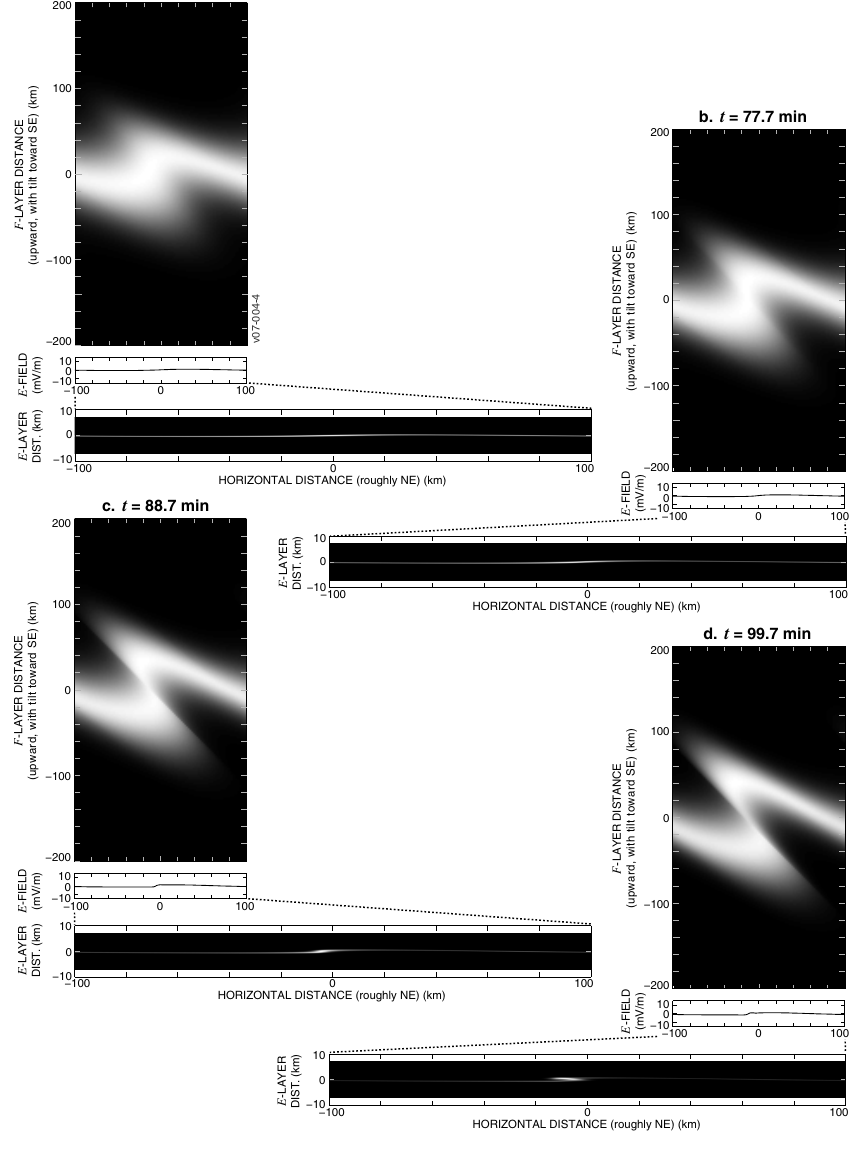
Figure 8: Coupled system evolution under resonant condition, with Σ H Σ = 1 . 0, and the E s layer at 105 km altitude. The PF boundary conditions are periodic in the horizontal direction. The axes are described in the first paragraphs of Section 4, and summarized in Figure 3.